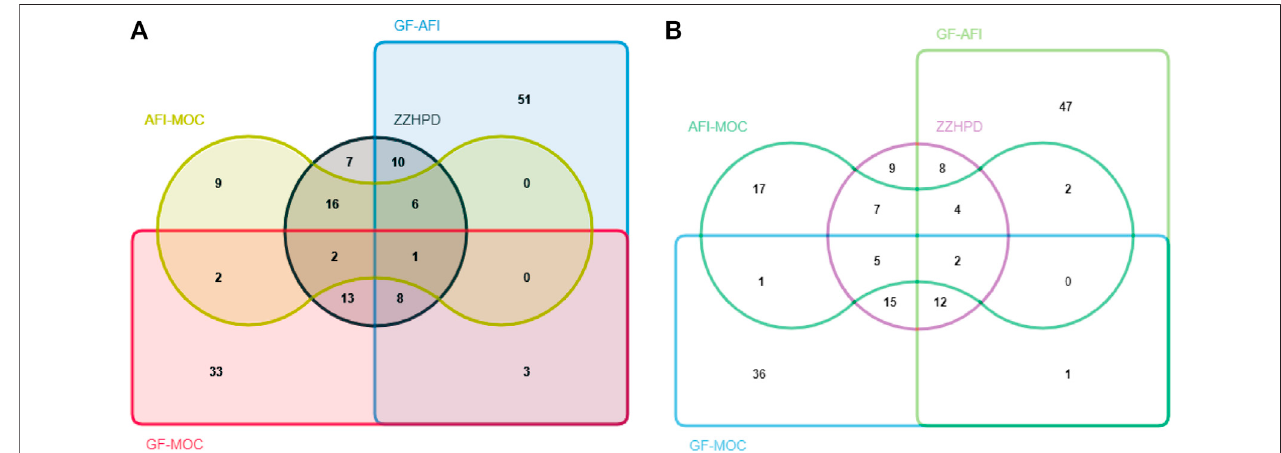
FIGURE5| TheBPIofbloodcomponentsofZZHPDunderthepositiveionmode( A )and negativeionmode( B );TheBPIofbraincomponentsofZZHPDunderthe positive ion mode ( C ) and negative ion mode ( D ).